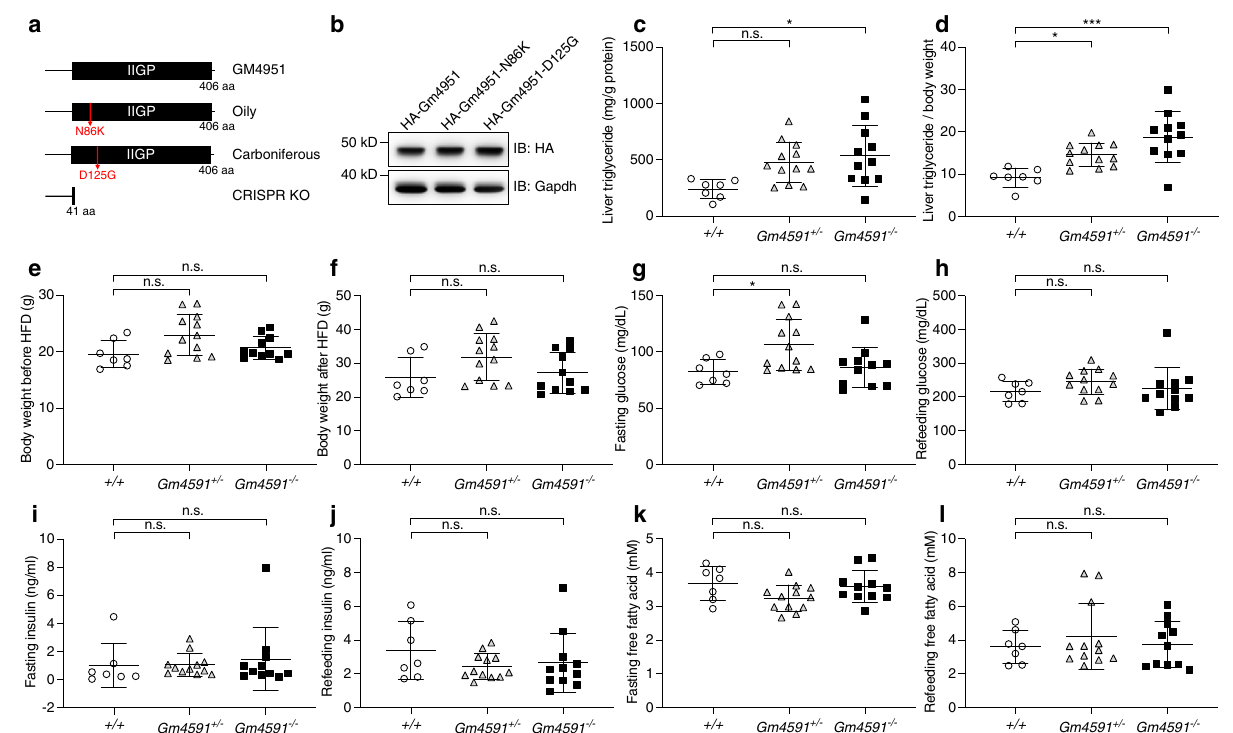
Fig. 2 Mutations in Gm4951 cause the Oily and Carboniferous phenotypes. a Protein domain diagrams of mouse GM4951 WT form, with the Oily mutation, Carboniferous mutation, and truncated form generated by CRISPR KO. b Immunoblots of lysates of 293T cells expressing HA-tagged WT GM4951, GM4951-N86K, and GM4951-D125G. c – l Liver triglycerides ( c ), liver triglycerides normalized by body weight ( d ), body weight before HFD ( e ), body weight after four weeks of HFD ( f ), overnight fasting glucose ( g ), glucose 2 h after refeeding ( h ), overnight fasting insulin ( i ), insulin 2 h after refeeding ( j ), overnight fasting free fatty acid ( k ), and free fatty acid 2 h after refeeding ( l ) plotted for WT ( + / + , n = 7), heterozygous ( Gm4951 + / − , n = 12), and homozygous Gm4951 CRISPR KO ( Gm4951 − / − , n = 11) mice. Data in ( c , d , and f ) were measured after 4 weeks on a HFD; data in ( g – l ) were measured after two weeks on a HFD. Each data point represents one mouse ( c – l ). Data are presented as means± SD. P values were determined by one- way ANOVA with Tukey ’ s multiple comparison test. P values are denoted by * P < 0.05; *** P < 0.001; ns, not signi fi cant with P > 0.05. The exact P values of statistically signi fi cant groups are: 0.0149 ( c , + / + vs Gm4951 − / − ); 0.0283 ( d , + / + vs Gm4951 + / − ) ; 0.0002 ( d , + / + vs Gm4951 − / − ) ; 0.0323 ( g , + / + vs Gm4951 + / − ) . Data are representative of two independent experiments ( b – l